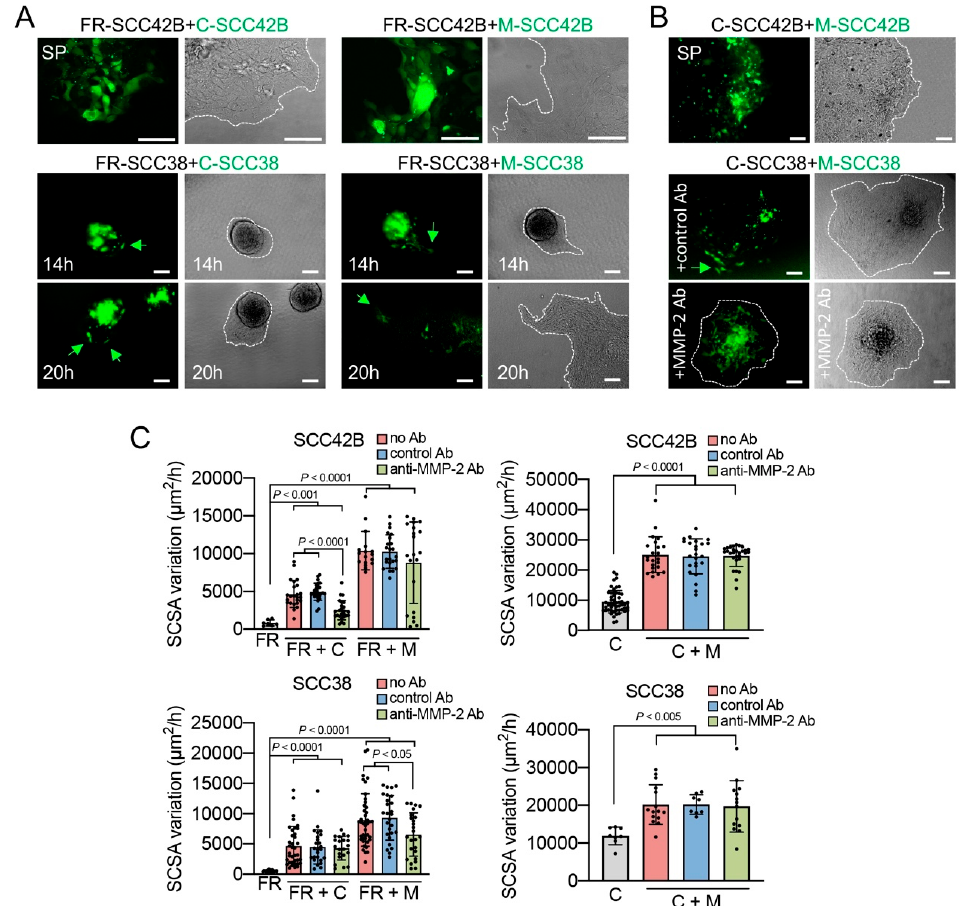
Figure 5. Mixed spheroids containing unlabeled FR-SCC cells plus either CMFDA-labelled C-SCC or CMFDA-labelled M-SCC cells were incubated for 14 or 20 h in the absence of antibodies or in the presence of control (anti-SDHB) or anti-MMP-2 antibodies. ( A , B ) Representative bright field and fluorescence images of the indicated mixed spheroids. Dashed white lines are indicated in the bright field images to delineate the periphery of the spheroid. Green arrows point to CMFDA-labelled SCC cells located at the front invasive positions. ( C ) Variations over time of the SCSA of the indicated spheroids. C: control cells, FR: FR-SCC cells, FR + C and FR + M: mixed spheroids containing unlabeled FR-SCC cells plus CMFDA-labelled C-SCC or CMFDA-labelled M-SCC cells, respectively. C + M: mixed spheroids containing unlabeled C-SCC cells plus CMFDA-labelled M-SCC. Data are presented as mean ± standard deviation from 3 individual experiments. Scale bars, 100 µm.